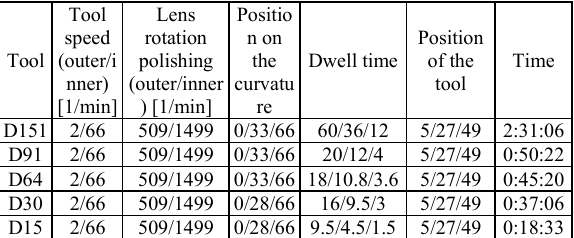
Table 3 . Parameter of the grinding processes for each tool .